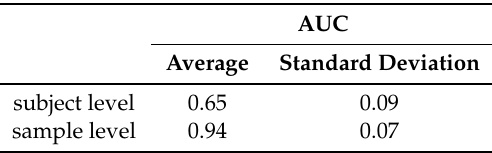
Table 5. Average AUC and the corresponding standard deviation when splitting at sample